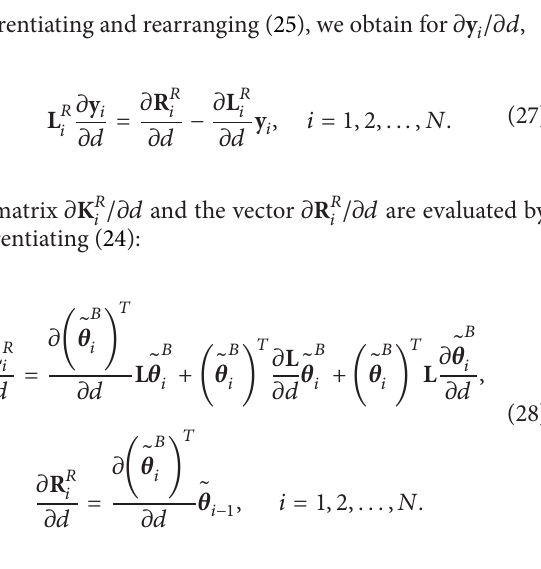
Algorithm 1: The produce of the proposed